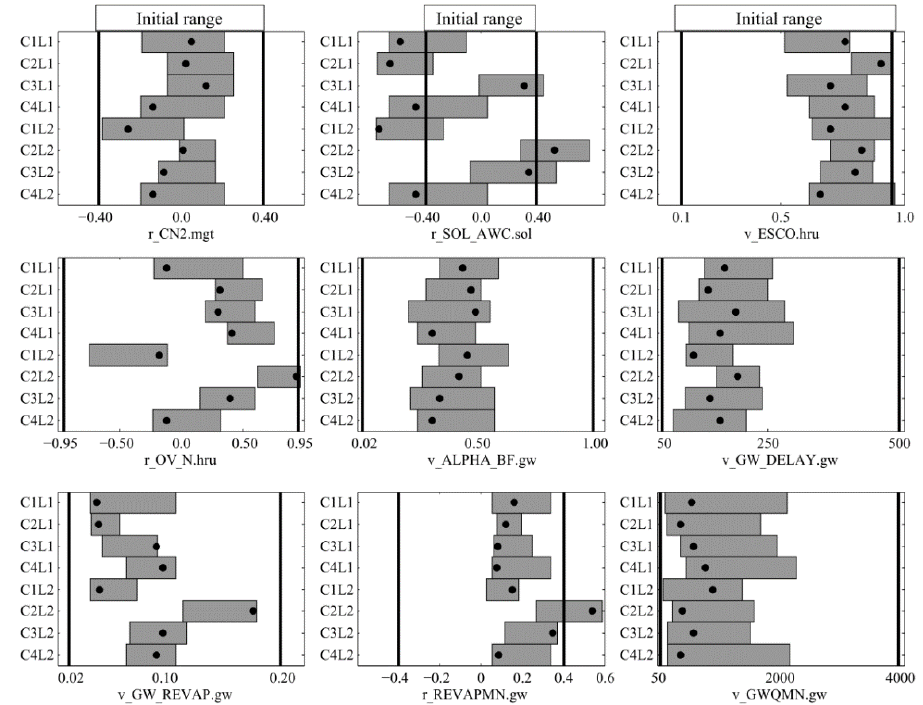
Figure 6. The initial (vertical lines) and final ranges (grey bars) of the parameters considered in the calibration. The dots show the best parameter sets based on the best value of the objective function. “v_” indicates an absolute change where the initial parameter value is replaced by another value. “r_” indicates a relative change where the initial parameters are multiplied by (1 + a given value).